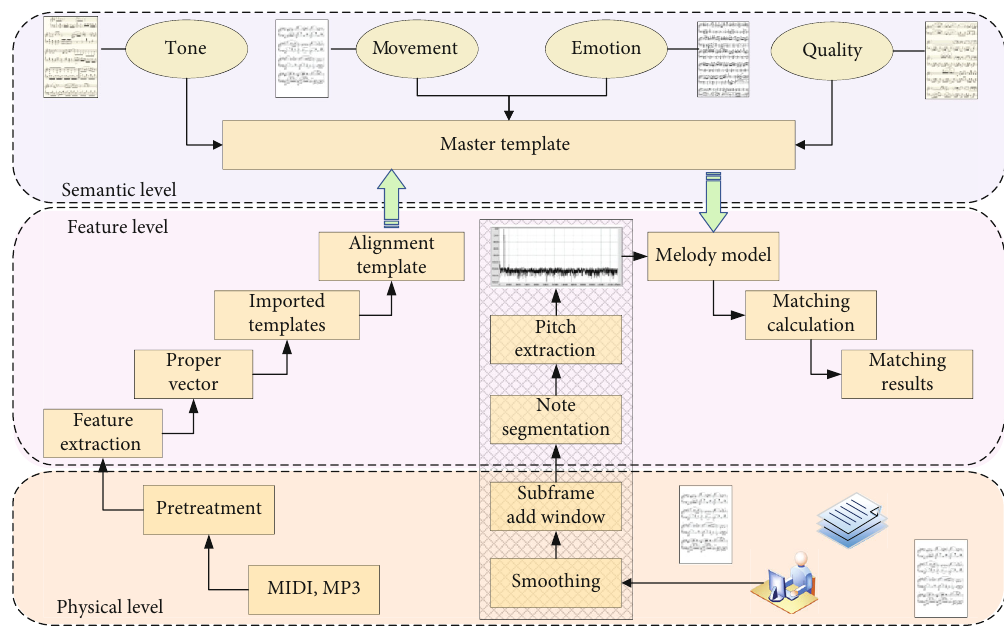
Figure 2: Semantic matching technology framework based on audio sentiment